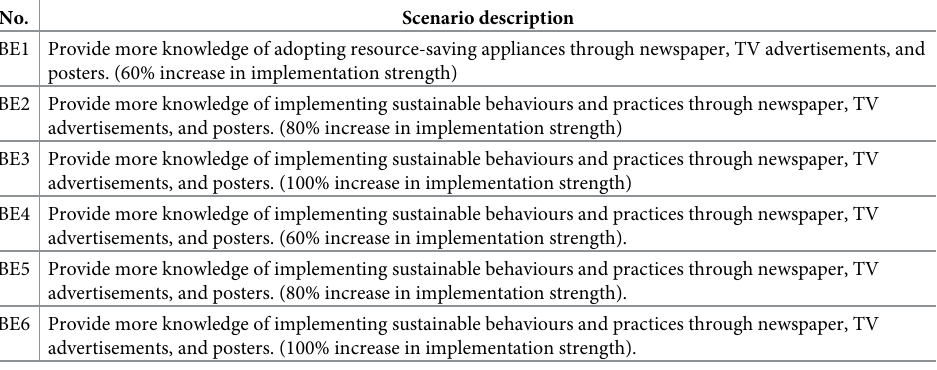
Table 2. Overview of FEW conservation strategies—general education & public will adjustment measures (BE). No.